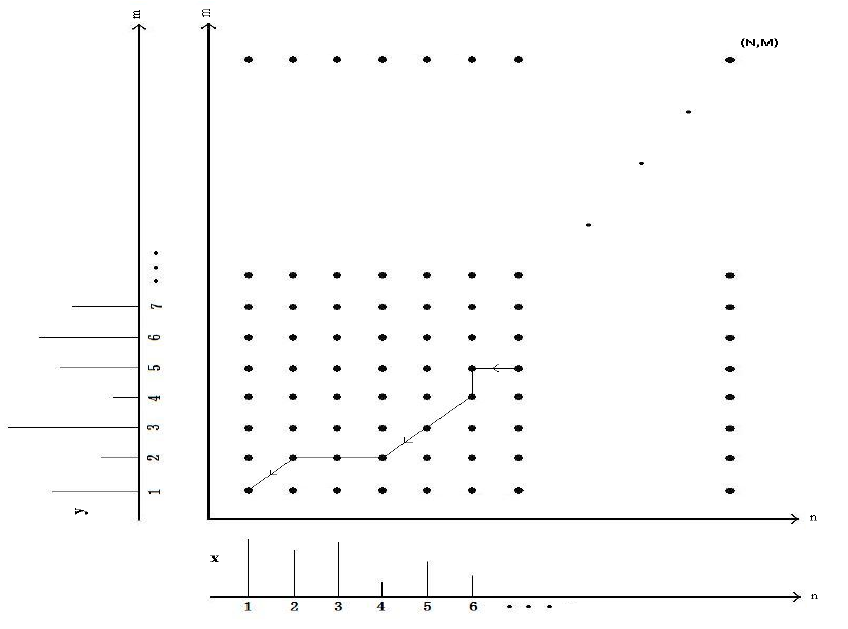
Figure 10. DTW mapping